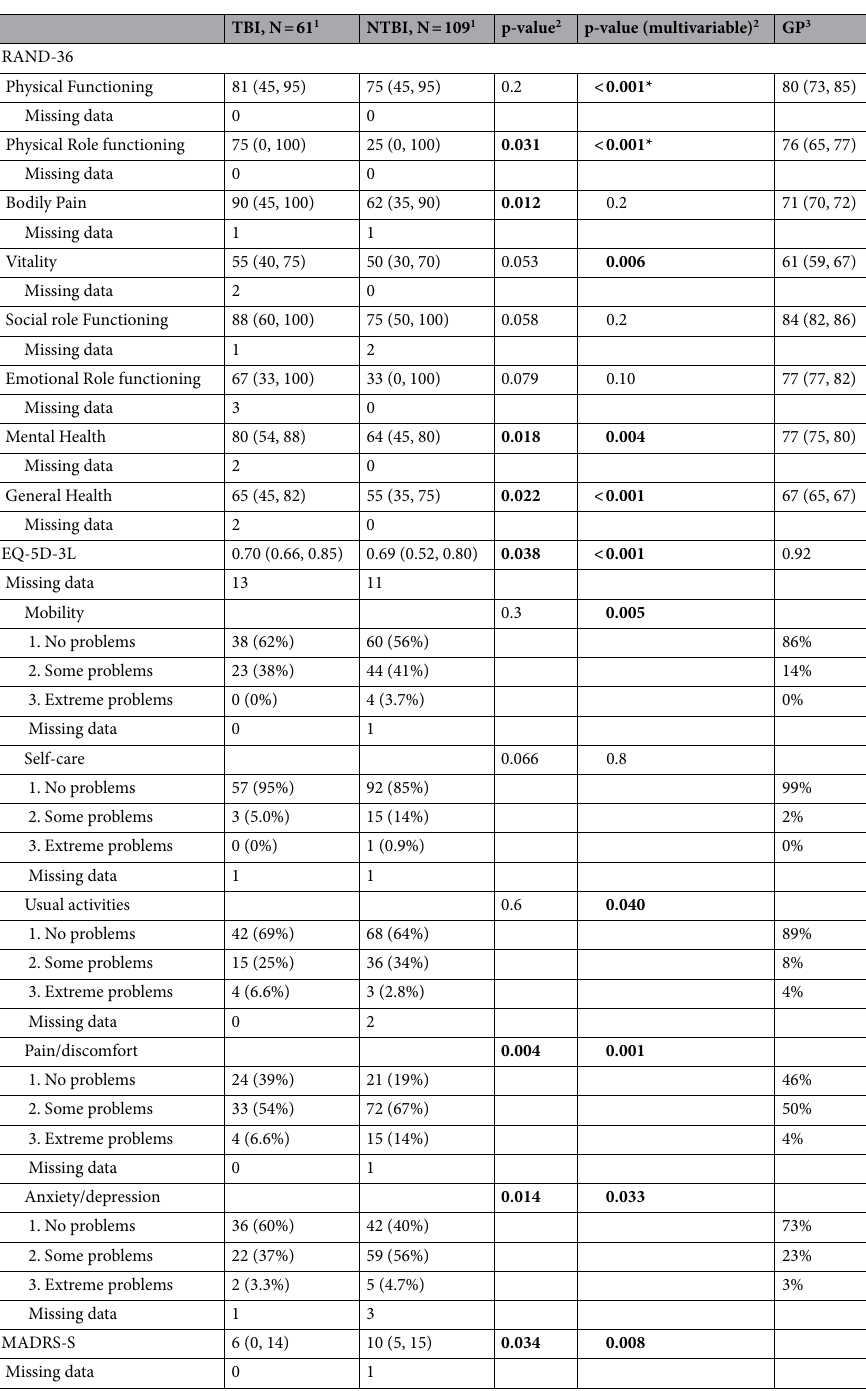
Table 2. Results TBI versus NTBI. Comparing health-related quality of life (HRQoL), assessed with RAND- 36 and EQ-5D, and symptoms of depression assessed with Montgomery Åsberg depression Rating Scale self-report (MADRS-S), in trauma patients with a concomitant traumatic brain injury (TBI) to trauma patients without (NTBI) and the general population (GP). 1. n (%); Median (IQR), 2. Mann Whitney U test; Proportional odds ratio comparing TBI and NTBI. 3. Age adjusted population values. Significant values are in bold. *Significant after Bonferroni